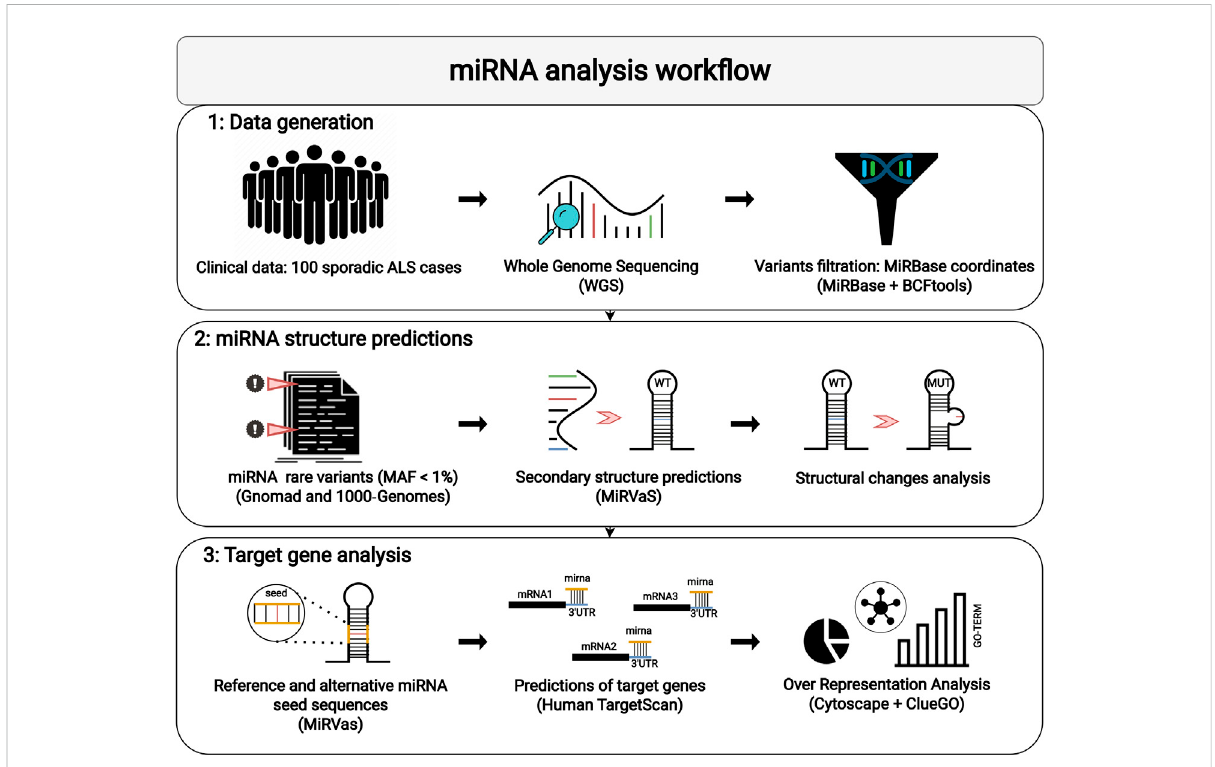
FIGURE 1 The work fl ow adopted for miRNA analysis is shown: (1) Selection of sporadic ALS patients for WGS and fi ltering of rare variants located in miRNAs; (2) Location ofvariants inmiRNA sequences and secondarystructures predictions; (3)Target analysis and ORA on reference and alternative miRNA seed sequences.